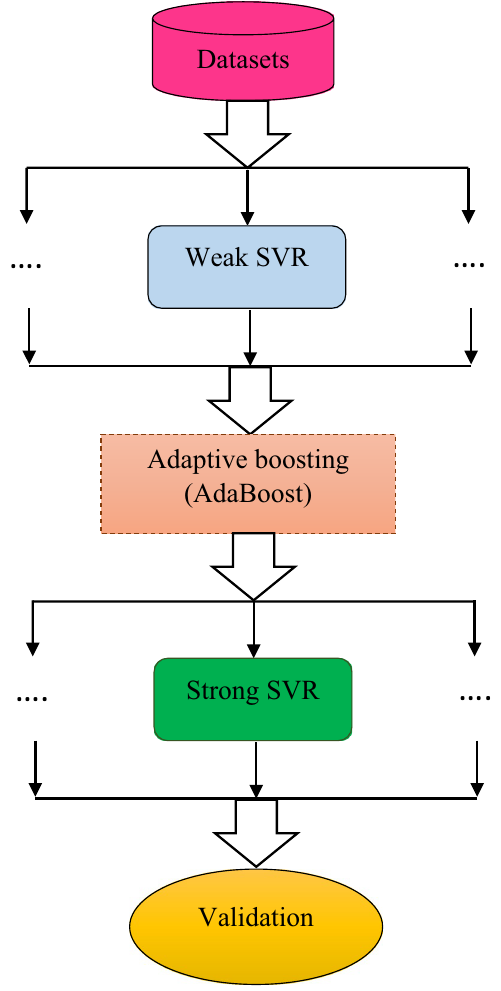
Figure 1. Schematic illustration of the proposed